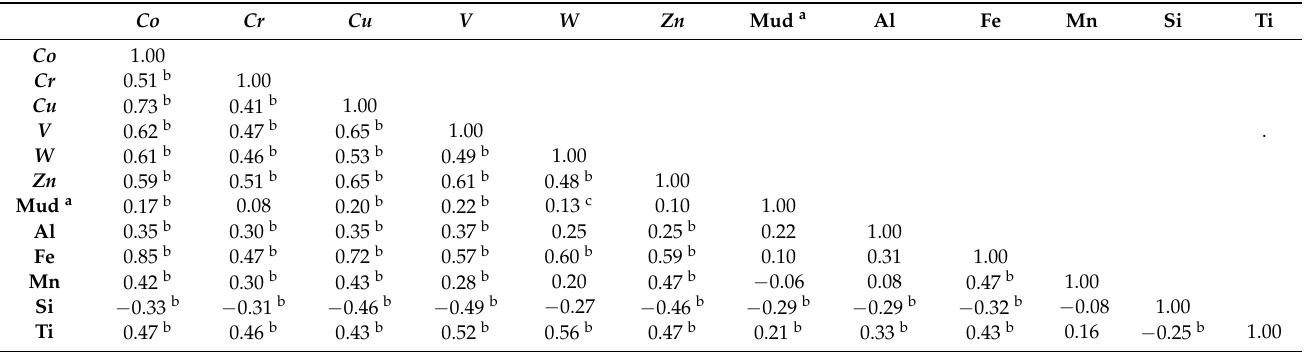
Table 1. Kendall’s tau b correlation coefficients between elements of the developed chemostrati- graphic fingerprints (italics, bold), grain size, and selected lithogenic (reference) elements.